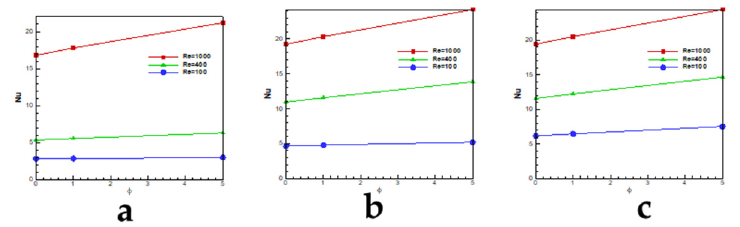
Figure 7. Variation of averaged Nusselt number, at different nanoparticles volume concentration at HR = 1. ( a ) Ra = 10 4 , ( b ) Ra = 10 5 , ( c ) Ra = 10 6 .